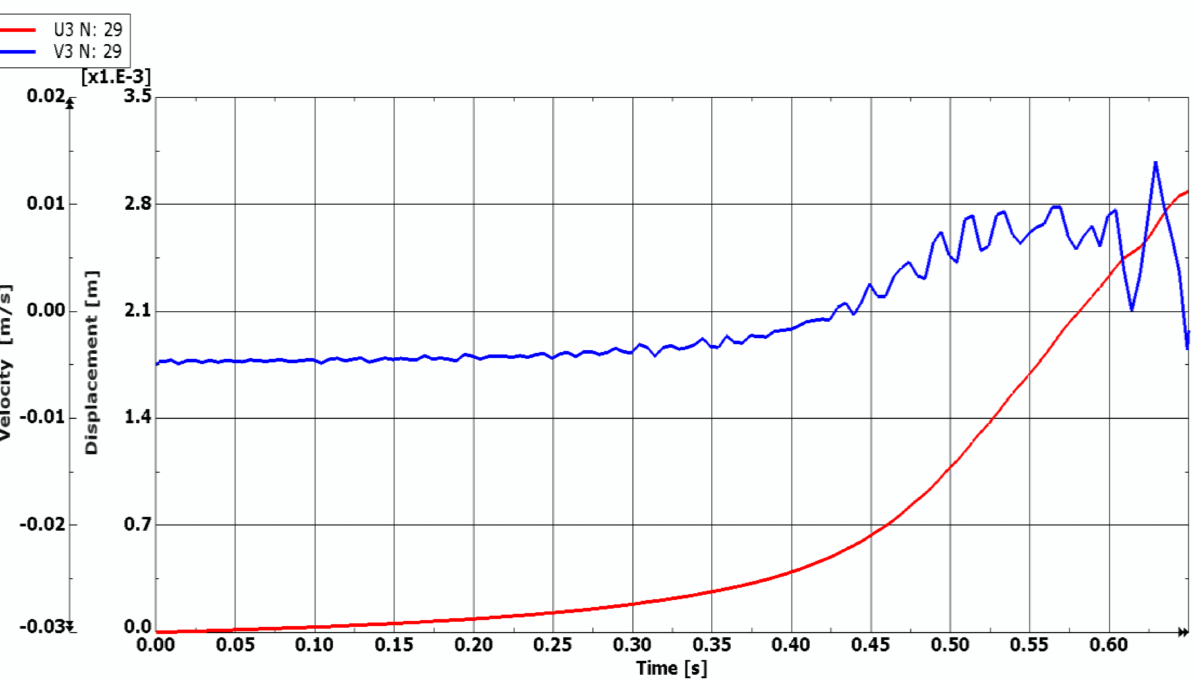
Figure 10. Time histories of deflection and velocity of deflection of quasi-isotropic plate with all fibers cracked in damaged facings represented by ( a ) FDM model, ( b ) FEM